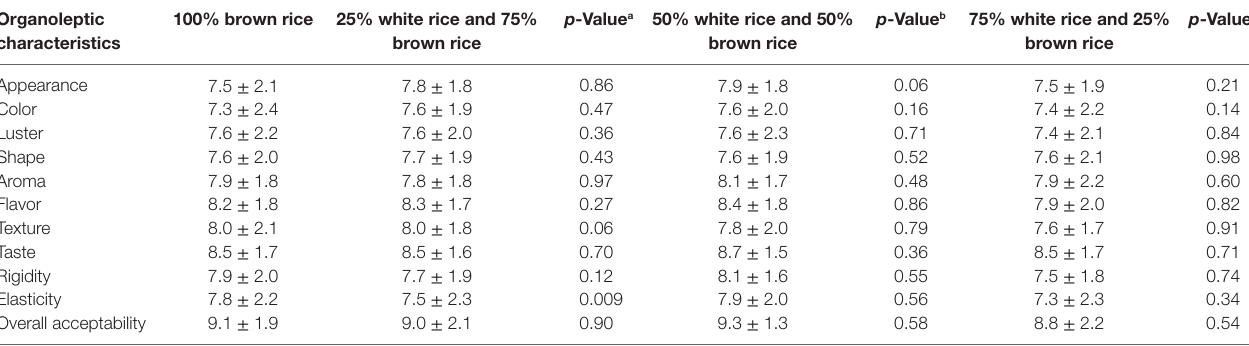
TaBle 4 | Comparison between organoleptic assessment of 100% brown rice to other rice meals. Organoleptic